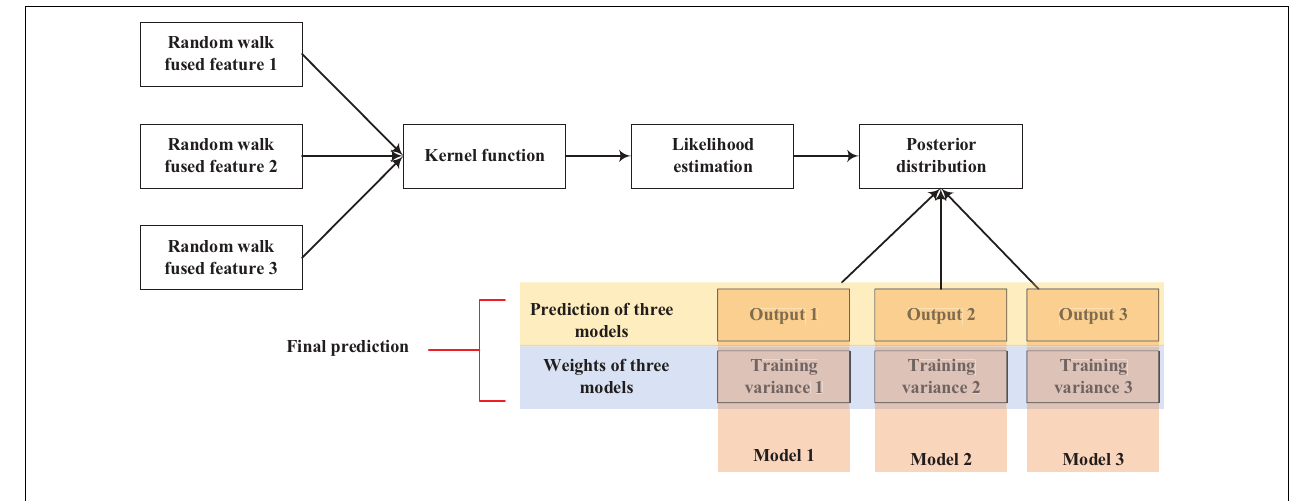
FIGURE 2 | Workflow of constructing RVM